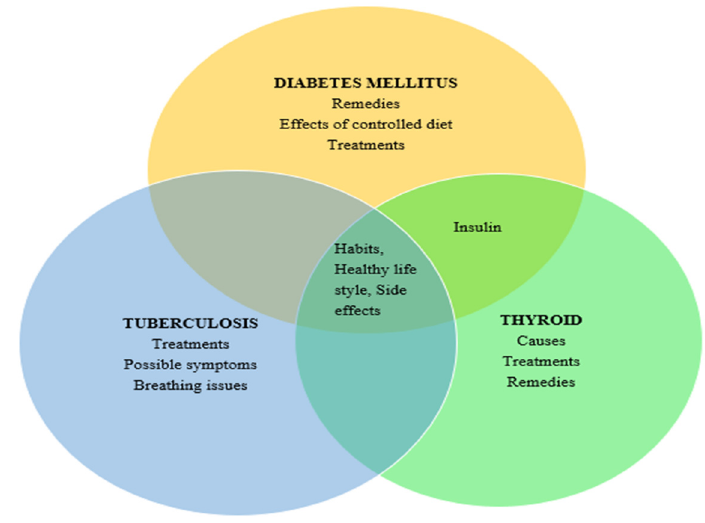
Figure 5. A Venn diagram summarization to depict inter-relationships between the three chronic